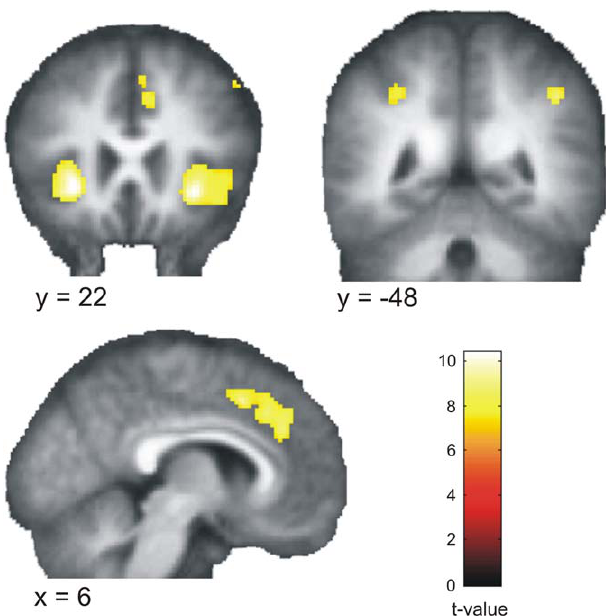
Figure 6. Study 2 Functional Imaging Data: Retrieval and Comparison Areas that show stronger activation ( p , 0.05, FWE corrected) for retrieval and comparison than encoding, rendered on coronal ( y ¼ 22 and y ¼(cid:2) 48, top left and right, respectively), and sagittal ( x ¼ 6, bottom left) sections of participants’ normalised average structural scan. See also Table S1 for exact MNI coordinates.